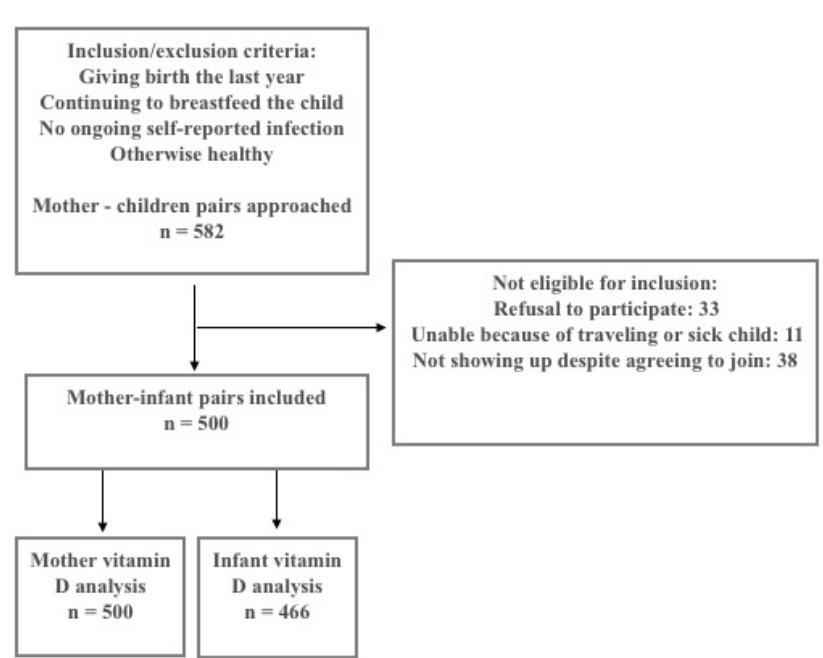
Figure 1. Study flow chart.